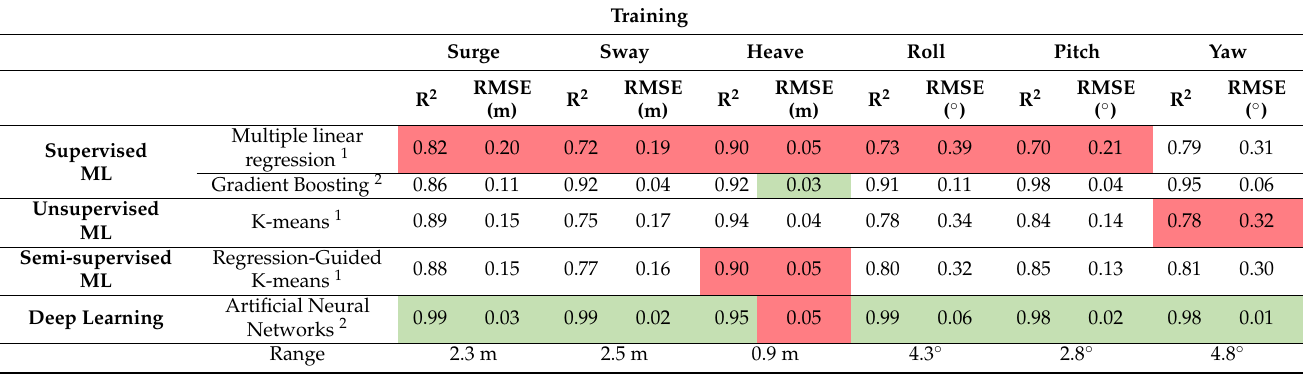
Table 4. Comparison of different ML and DL algorithms for prediction of the 6 DoF of moored ship motions. Quantification of error, RMSE; correlation, R 2 . In green, the highest values of fit, and in red, the poorest value of fit, for each case of all algorithms. The values of the measurements range for each type of motion are also indicated. Training phase.